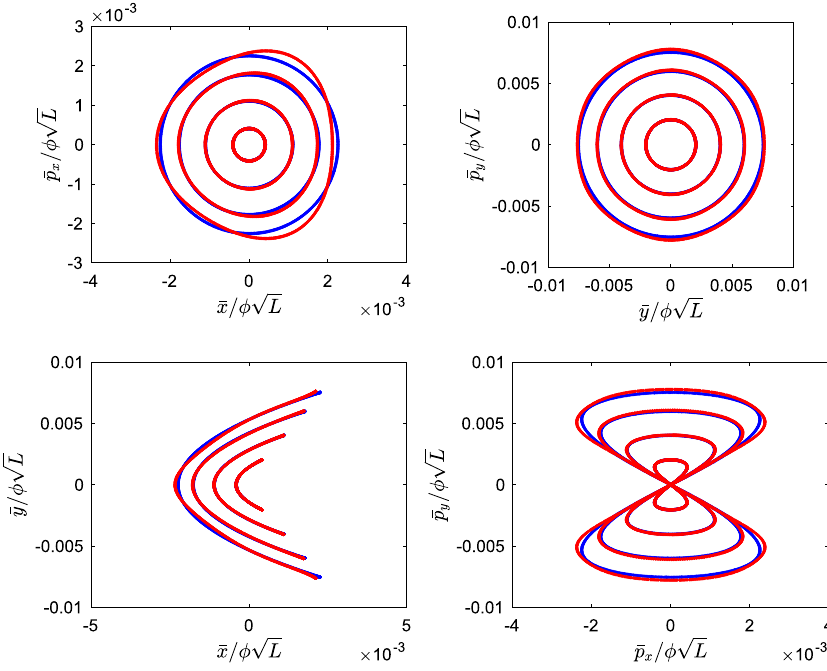
− 2 ν 0 . 618 with ν x y x ¼